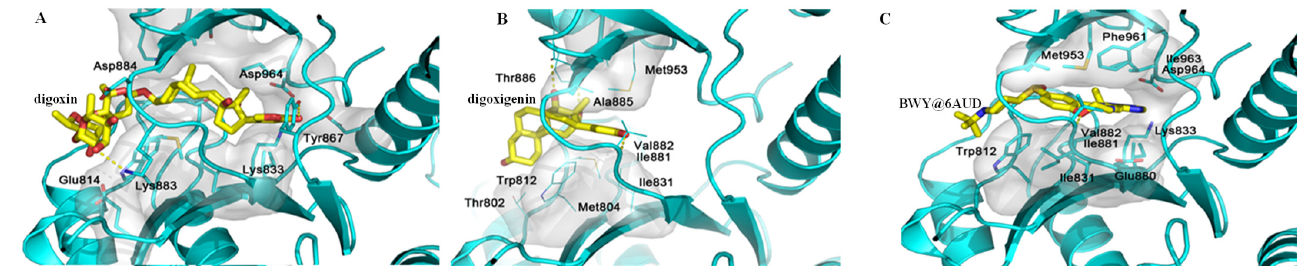
Figure 7. Docking profiles for digoxin, digoxigenin, and BWY, a phosphoinositide 3-kinase (PI3K) inhibitor, and PI3K. The rigid steroid core and the long glycosyl group of digoxin (yellow) prohibit it from fitting into the pocket of PI3K, and thus this cardiac glycoside does not bind to PI3K ( A ). However, the steroid motif of digoxigenin (yellow) may form a pi–pi interaction with Tyr812, and its hydroxy groups at the C-12 and C-14 positions form hydrogen bonds with the sidechains of PI3K. Additionally, the lactone unit of digoxigenin would interact with the entrance of pocket of PI3K, and thus this aglycone could interact with PI3K ( B ). Strong binding was observed for BWY (yellow) and PI3K ( C ).